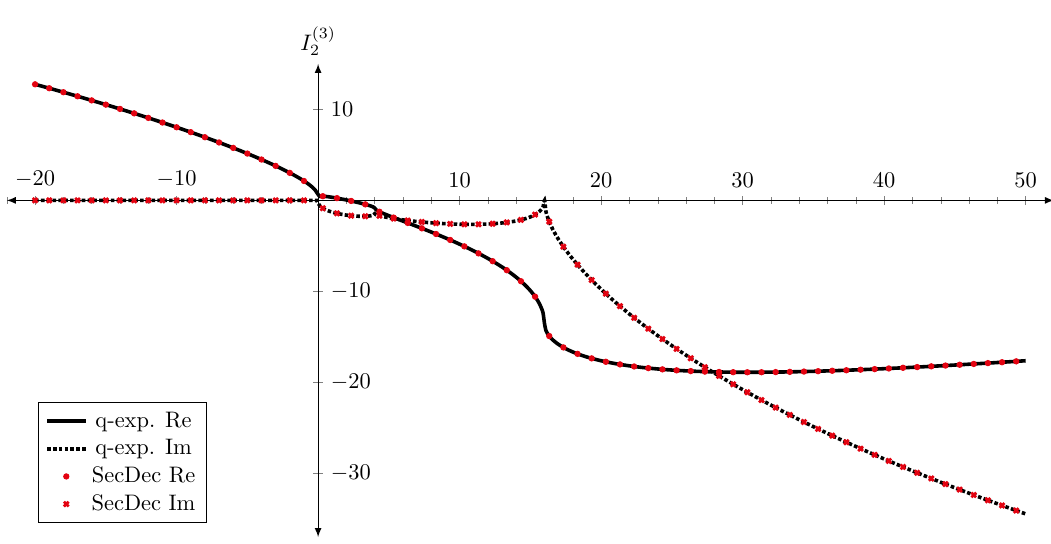
with numerical results from SecDec. The ¯ q -expansion 2